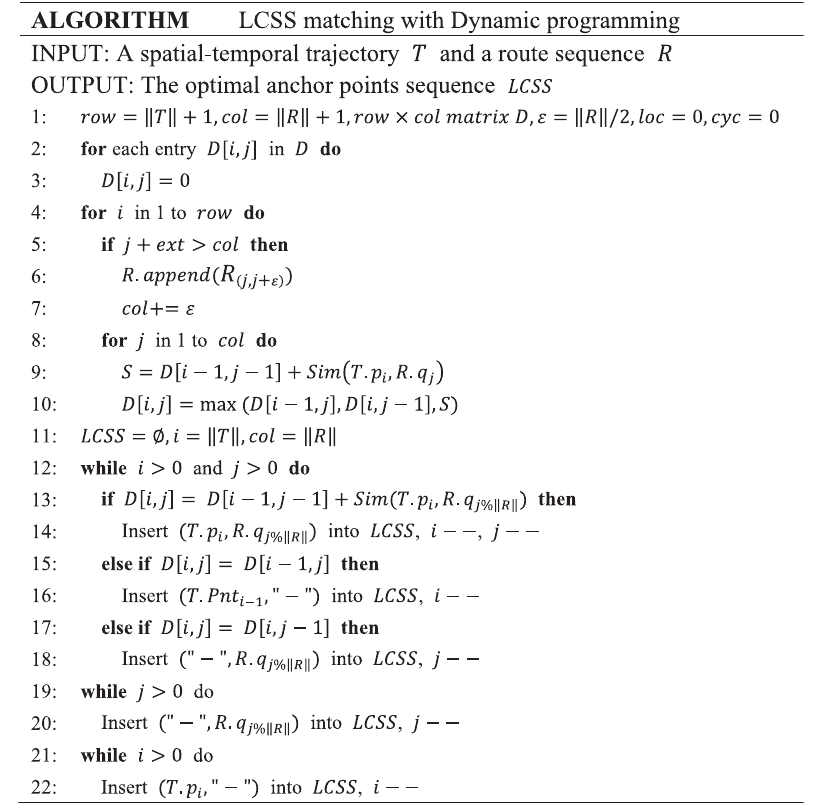
Figure 3: LCSS extension for periodic